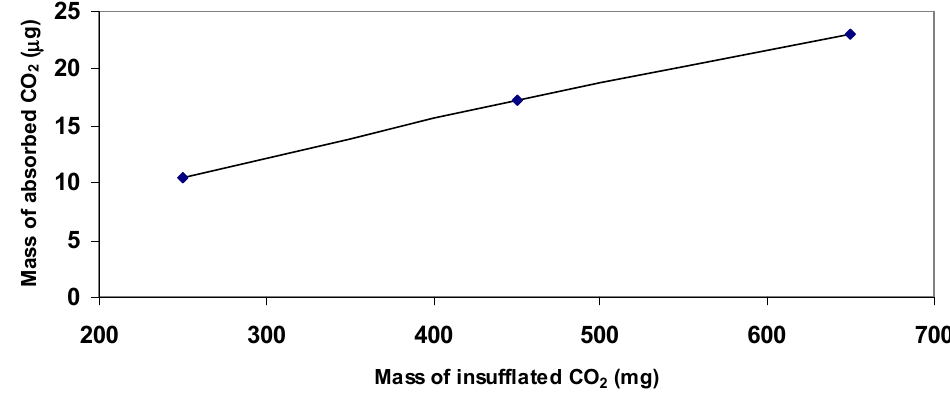
Figure 6. Linear absorption of gas into the composite matrix in relation to the environmental concentration of CO 2